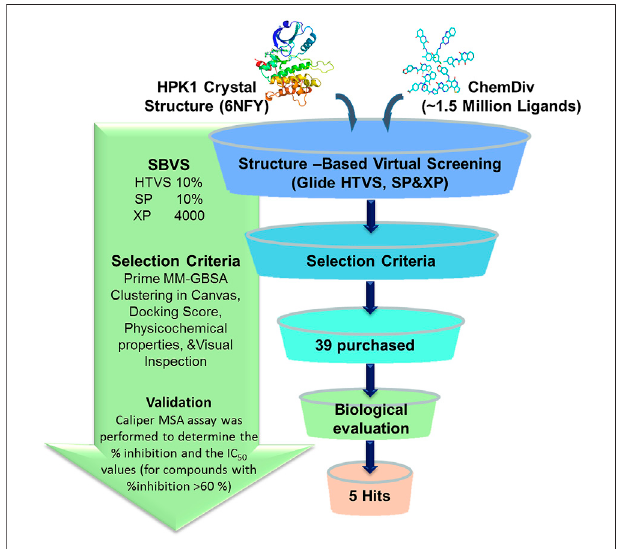
FIGURE 1 | Flowchart of structure-based virtual screening and in vitro kinase inhibition assay for HPK1